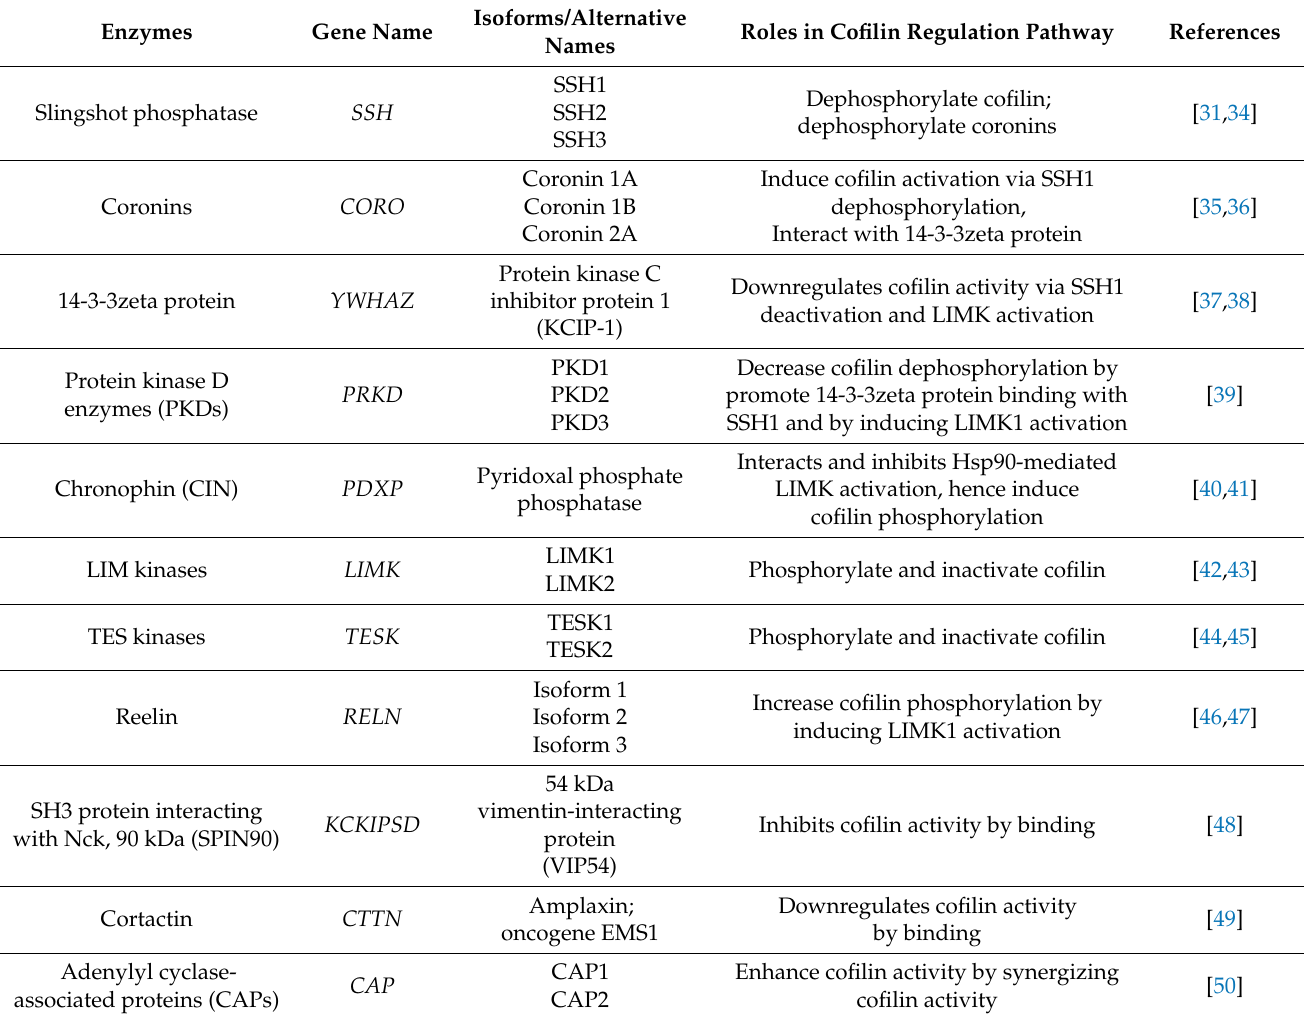
Table 1. Short overview of the functional modulators of